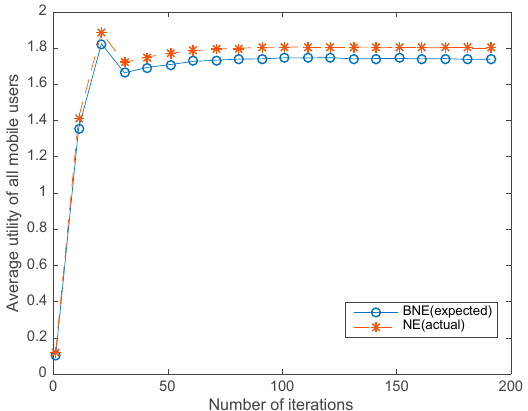
Figure 8. Average utility of all mobile users obtained through Bayesian Nash equilibrium (BNE) and Nash equilibrium (NE).